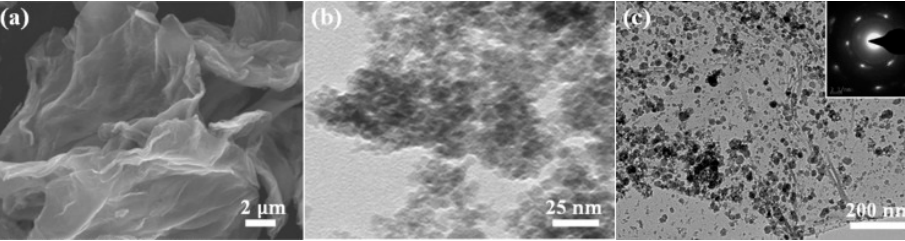
Figure 11. SEM images of ( a ) rGO, ( b ) ZTO nanoparticles, and ( c ) 8ZTO/rGO [92].